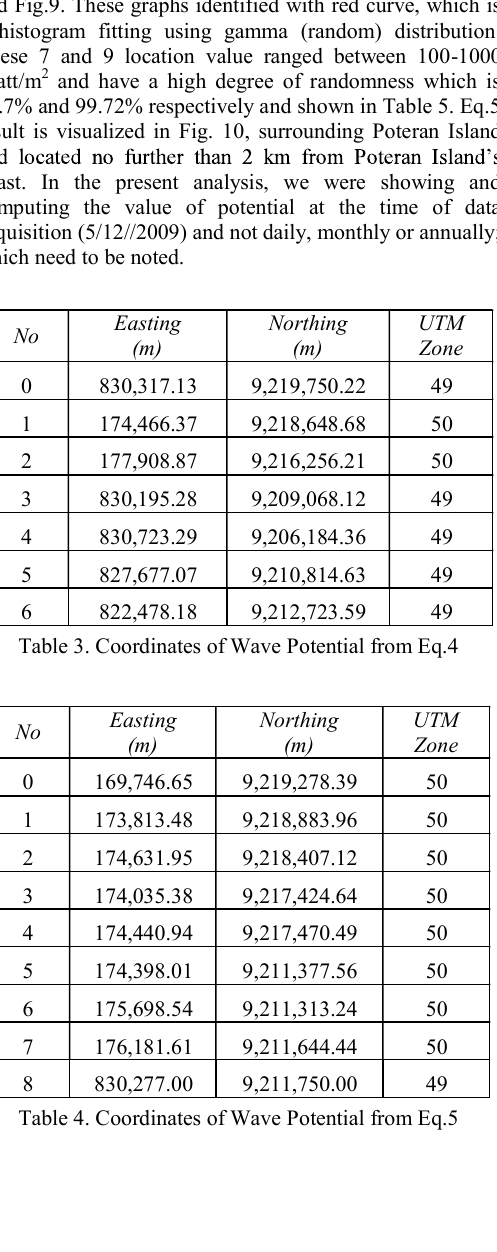
Table 4. Coordinates of Wave Potential from